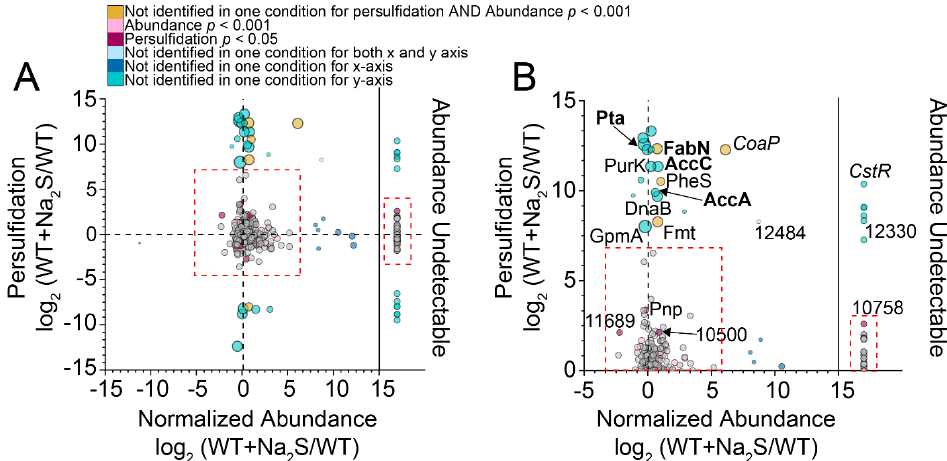
Figure 2. Changes in protein persulfidation relative to changes in protein abundance in E. faecalis before and after the addition of exogenous sulfide. ( A ) Log – log plot of the change in protein persul- fidation (WT + Na 2 S/WT) vs. change in protein abundance (WT + Na 2 S/WT). Each circle represents a single protein identified as persulfidated, colored according to the significance threshold in the legend. The red dashed boxes include proteins whose persulfidation status and/or normalized abundance was detectable in both WT and WT + Na 2 S samples. Proteins outside these boxes were not detectable in one or more conditions and utilized a peak area one order of magnitude lower than the lowest detectable protein to calculate persulfidation or abundance changes. ( B ) Expanded view of proteins of which their persulfidation status increased after the addition of exogenous sulfide, with select proteins annotated with the protein name or locus tag (OG1RF_xxxxx). An evaluation of protein thiols for which we have total persulfidation and abundance data, i.e . , detectable and persulfidated in both conditions, revealed that a majority did not have a statistically significant change in persulfidation status or fractional abundance. This supports the idea that the proteome functions as a sink for sulfane sulfur that is not greatly impacted by the addition of a high dose of exogenous Na 2 S to cells [7,13]. Those proteins that are more likely to represent regulatory targets via persulfidation are those that are only identified as persulfidated under conditions of Na 2 S treatment, the majority of which may exhibit only small statistically significant changes in cell abundance (Figure 2B). A striking exception to this was CoAPR, which exhibited a large increase in protein abundance after the addition of Na 2 S due to the transcriptional derepression by CstR [12] with only the cysteine derived from the C-terminal rhodanese domain (C508) identified as persulfidated in Na 2 S-treated cells (Supplemental Table S2). Other persulfidated proteins of note in this analysis included phosphotransacetylase (Pta), which catalyzed the reversible interconversion of acetyl-CoA and acetyl phosphate, and cysteines in enzymes involved in type II fatty acid biosynthesis (FAS), including AccA, AccC and FabN (Figure 2B; Supplemental Figure S3) [61,62]. AccA and AccC are part of a four-enzyme acetyl-CoA carboxylase (ACCase) complex, which defines the ini- tial and committed step of FAS, carboxylating acetyl-CoA to make malonyl-CoA prior to linkage to the acyl-carrier protein (ACP) [62,63]. FabN is a bifunctional enzyme, pos- sessing both 3-hydroxydecanoyl-ACP dehydratase activity, to create trans -2-decanoyl- ACP, and isomerase activity, converting trans -2-decenoyl-ACP to cis -3-decanoyl-ACP [64]. FabN is functionally analogous to, although structurally distinct from, FabA in E. coli , which defines a major point of regulation of the ratio of unsaturated to saturated fatty acids [61]. As such, Ef mutants lacking FabN exhibited unsaturated fatty acid auxotrophy, which could be partly rescued by supplementation by oleic acid (18:1) [65], revealing that Ef FabN is critically important in the biosynthesis of longer chain, unsaturated fatty acids [64]. Additionally, two other enzymes involved in FAS, including AccB (C119) of the AC- Case complex and the primary β -ketoacyl-ACP synthase II, FabF (C262), were also per- sulfidated (Supplemental Figure S3, Supplemental Table S2). If persulfidation is